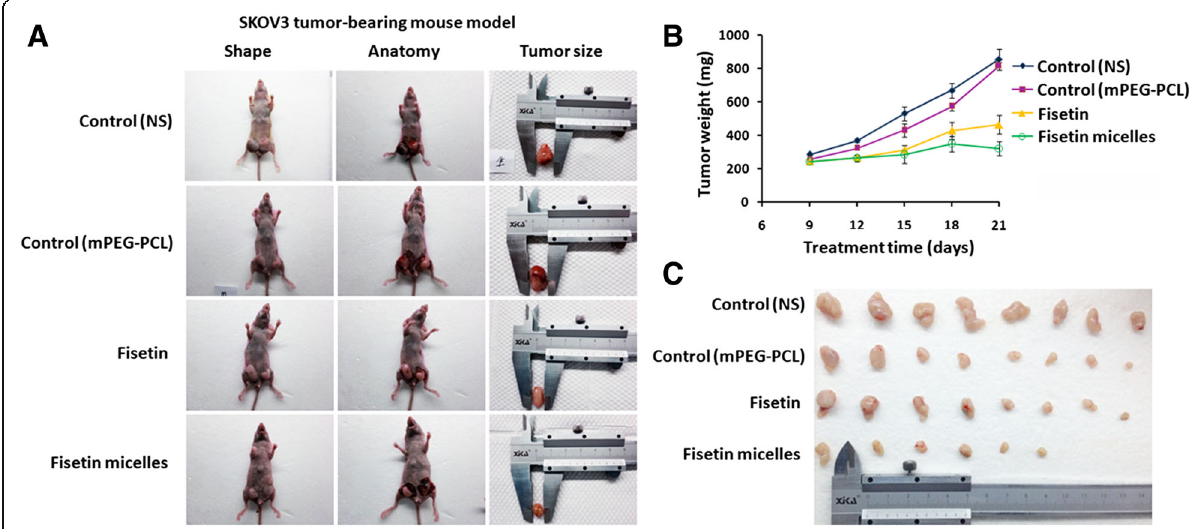
Fig. 5 Fisetin and fisetin micelles inhibit tumor growth in a xenograft model of ovarian cancer. a Xenograft mice were implanted with 5 × 10 6 SKOV3 cells on day 0 and were randomly divided into various treatment and control groups ( n =5). b Eight days after implantation, tumor-bearing mice were treated every week according to the protocols. c Tumor-bearing mice were treated with fisetin/fisetin micelles or received the vehicles, either DMSO or mPEG-PLC by intraperitoneal administration for 4 weeks, 4 consecutive days per week with either fisetin or fisetin micelles (50 mg/kg or 100 mg/kg). ( p <0.01, compared to control to be considered as